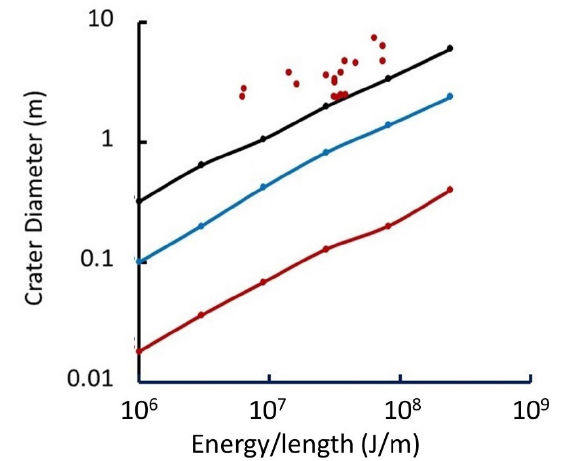
Figure 3. Solid lines show crater diameter in granite (red), clay-sand (blue), and peat (black) as a function of the energy/length from CTH simulations. The data points show the diameter of fractured granite from reference [37].